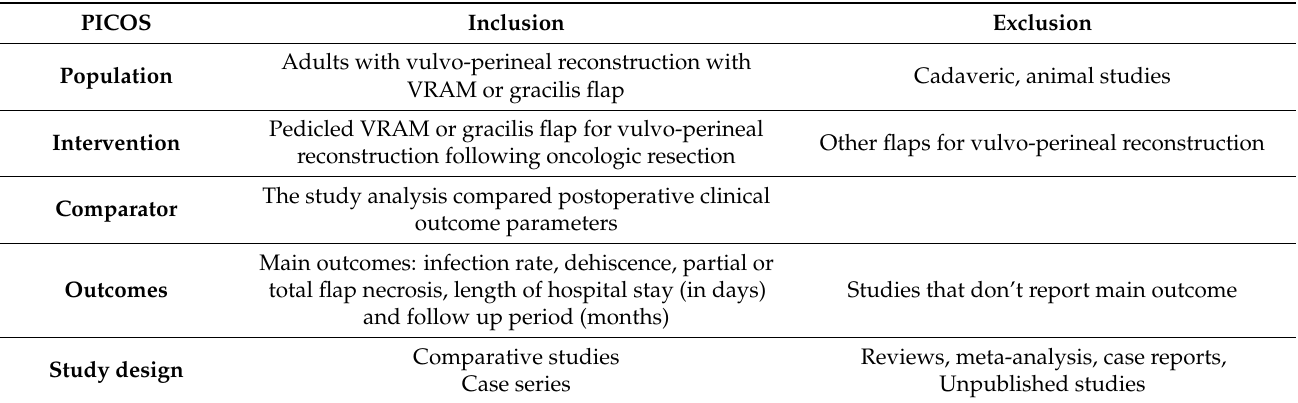
Table 1. Inclusion/exclusion